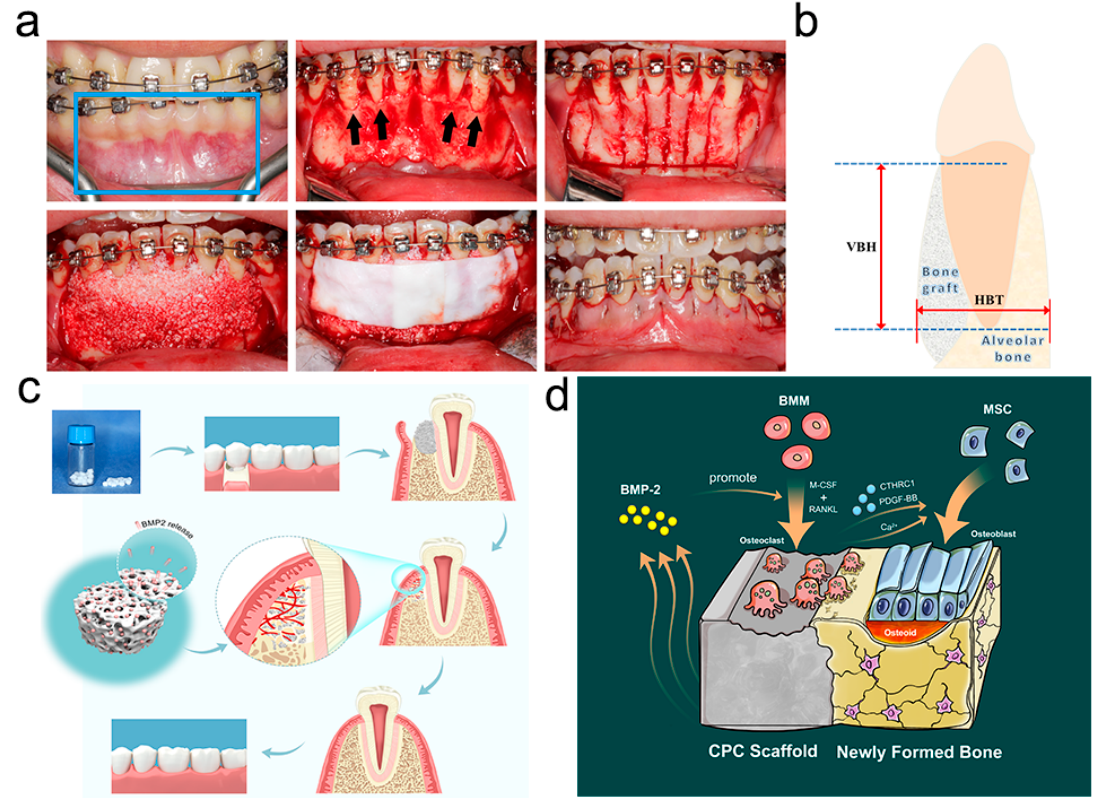
Figure 7. PAOO surgery and Schematic diagrams. ( a ) PAOO surgery in the anterior mandibu- lar region (blue box marks the surgical region, and black arrows mark the sites of alveolar bone dehiscence); ( b ) schematic diagram of the radiographic evaluation; ( c ) schematic diagram of